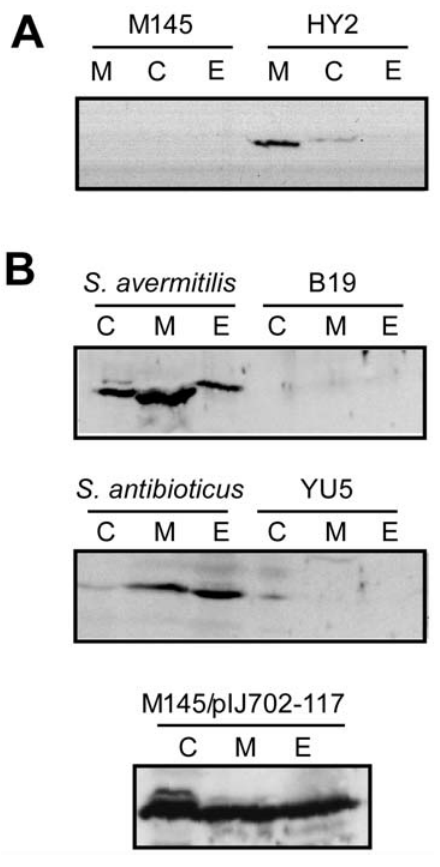
Figure 2. Cellular locations of MelD2 and MelC2. Samples of 10 ml of Streptomyces cultures grown to late log phase in TSB were harvested. Cytosolic (C), membrane (M), and extracellular (E) fractions of the cultures were fractionated and the proteins separated by SDS gel electrophoresis. MelD2-His and MelC2 proteins were detected by immunoblotting using anti-polyhistidine (A) and anti-MelC2 (B) antibodies, respectively. B19 is a D melC mutant of S. avermitilis isolated in this study. YU5 is a D melC mutant of S. antibioticus isolated previously [10]. M145/pIJ702-117 is M145 harbouring pIJ702-117, a high-copy- number plasmid containing the melC operon from S. antibioticus under a strong promoter [27].